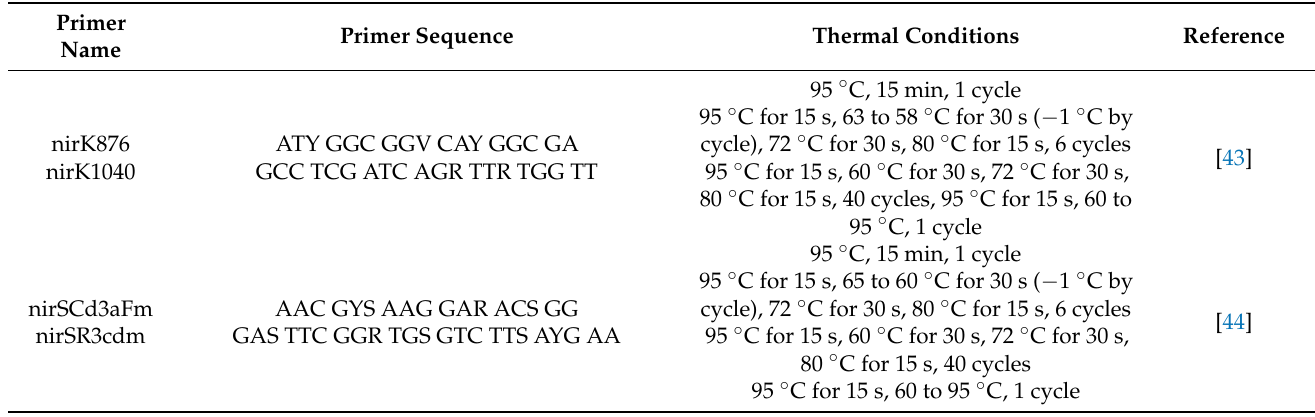
Table 2. Conditions for assessing abundance of nirK and nirS genes by q PCR